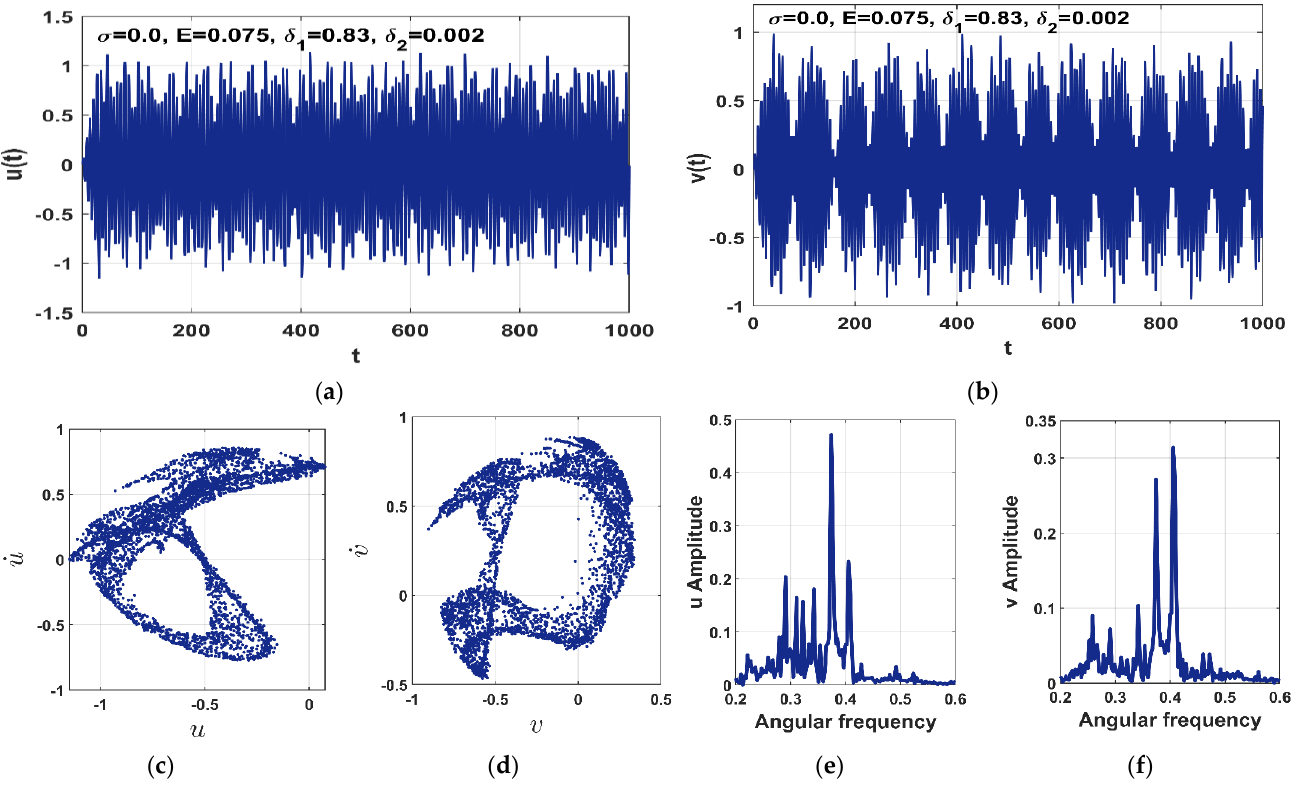
Figure 10. Chaotic time-response, Poincar é -map, and frequency-spectrum of the controlled Jeffcott- rotor according to Figure 7 (i.e., at σ = 0, δ 1 = 0.83, δ 2 = 0.002) when E = 0.075: ( a , b ) the normalized temporal oscillations u ( t ) and v ( t ) in X and Y direction, ( c , d ) the corresponding Poincar é -map, ( e , f ) the corresponding frequency-spectrum.